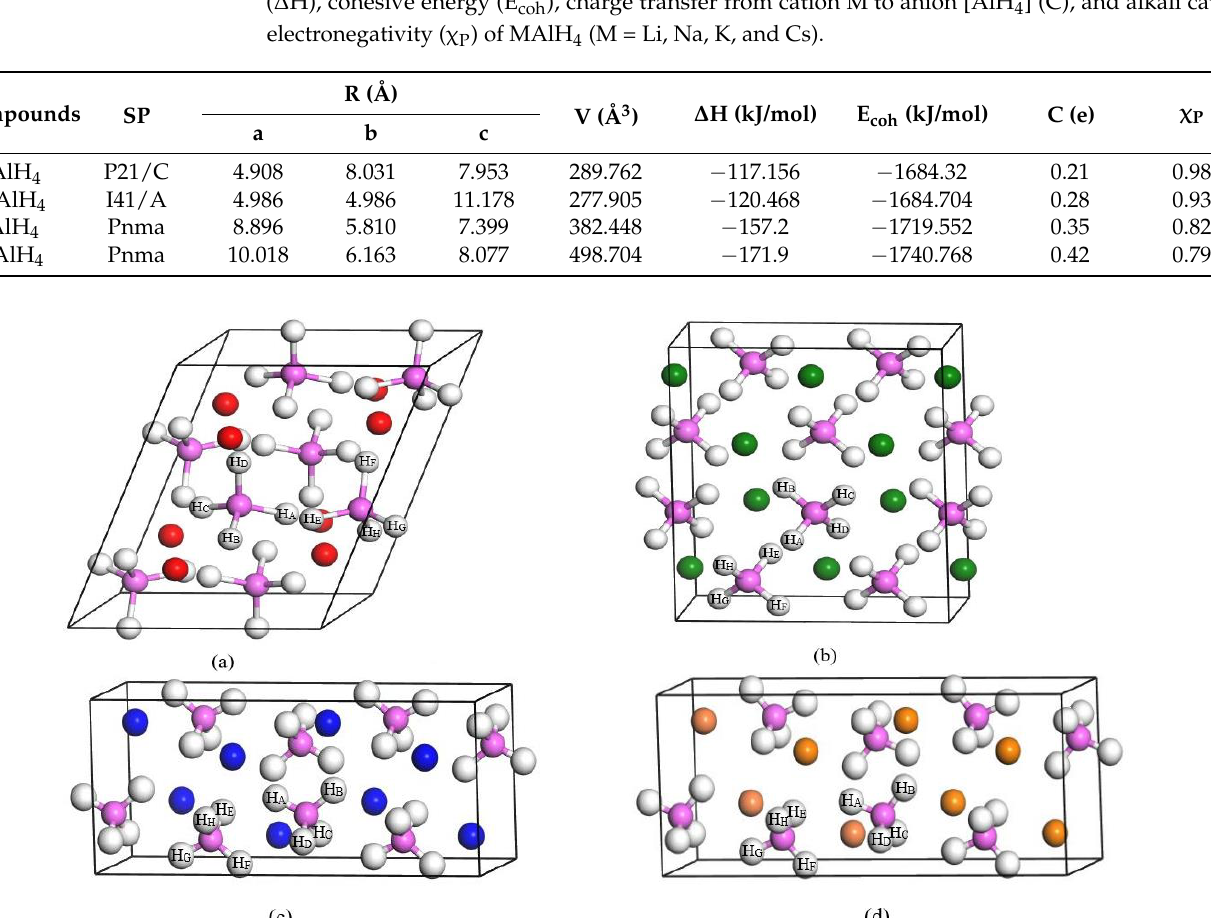
Figure 1. The crystal models of MAlH 4 (M = Li, Na, K, and Cs) with 2 × 1 × 1 supercell: ( a ) LiAlH 4 , ( b ) NaAlH 4 , ( c ) KAlH 4 , and ( d ) CsAlH 4 . Li, Na, K, Cs, Al, and H atoms are denoted by red, green, blue, orange, pink, and white spheres, respectively. The H atoms labeled as H A , H B , H C , H D , H E , H F , H G , and H H in two [AlH 4 ] units are considered for hydrogen desorption. Table 1. The space group (SP), relaxed lattice parameters (R) and cell volume (V), formation en- thalpy (ΔH), cohesive energy (E coh ), charge transfer from cation M to anion [AlH 4 ] (C), and alkali cation electronegativity (χ P ) of MAlH 4 (M = Li, Na, K, and Cs).